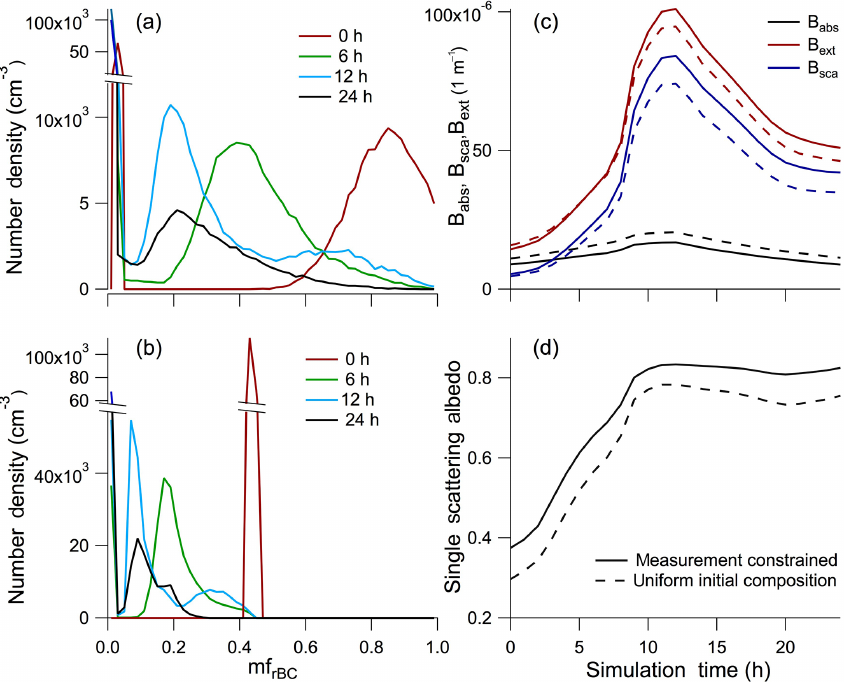
Figure 7. Evolution of dry mf rBC for the measurement-constrained (a) and uniform initial (b) mixing state cases. See Sects. 2 and S3 for a description of the model input parameters. Evolution of volume absorption ( B abs ), scattering ( B scat ), and extinction ( B ext ) coefficients at 550nm (c) and single scattering albedo (SSA) at 550nm over the 24h simulation period (d) for measurement constrained (solid lines) and uniform initial mixing state (dashed lines)